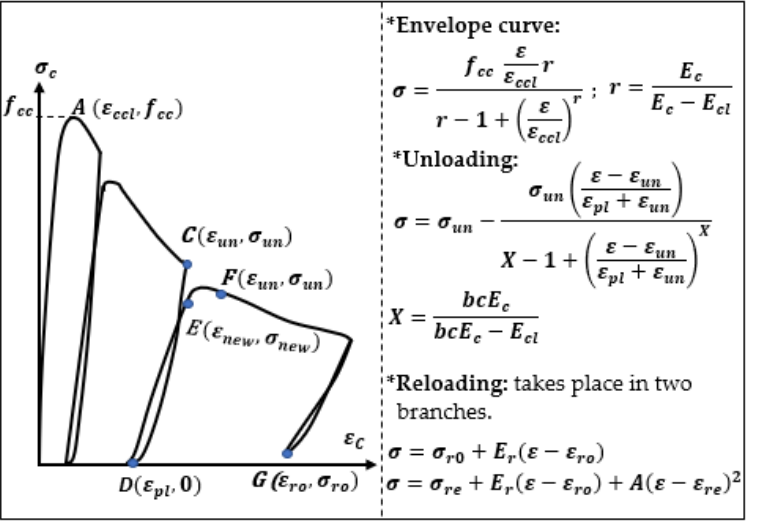
Figure 5. Concrete model according Mander et al. [31].